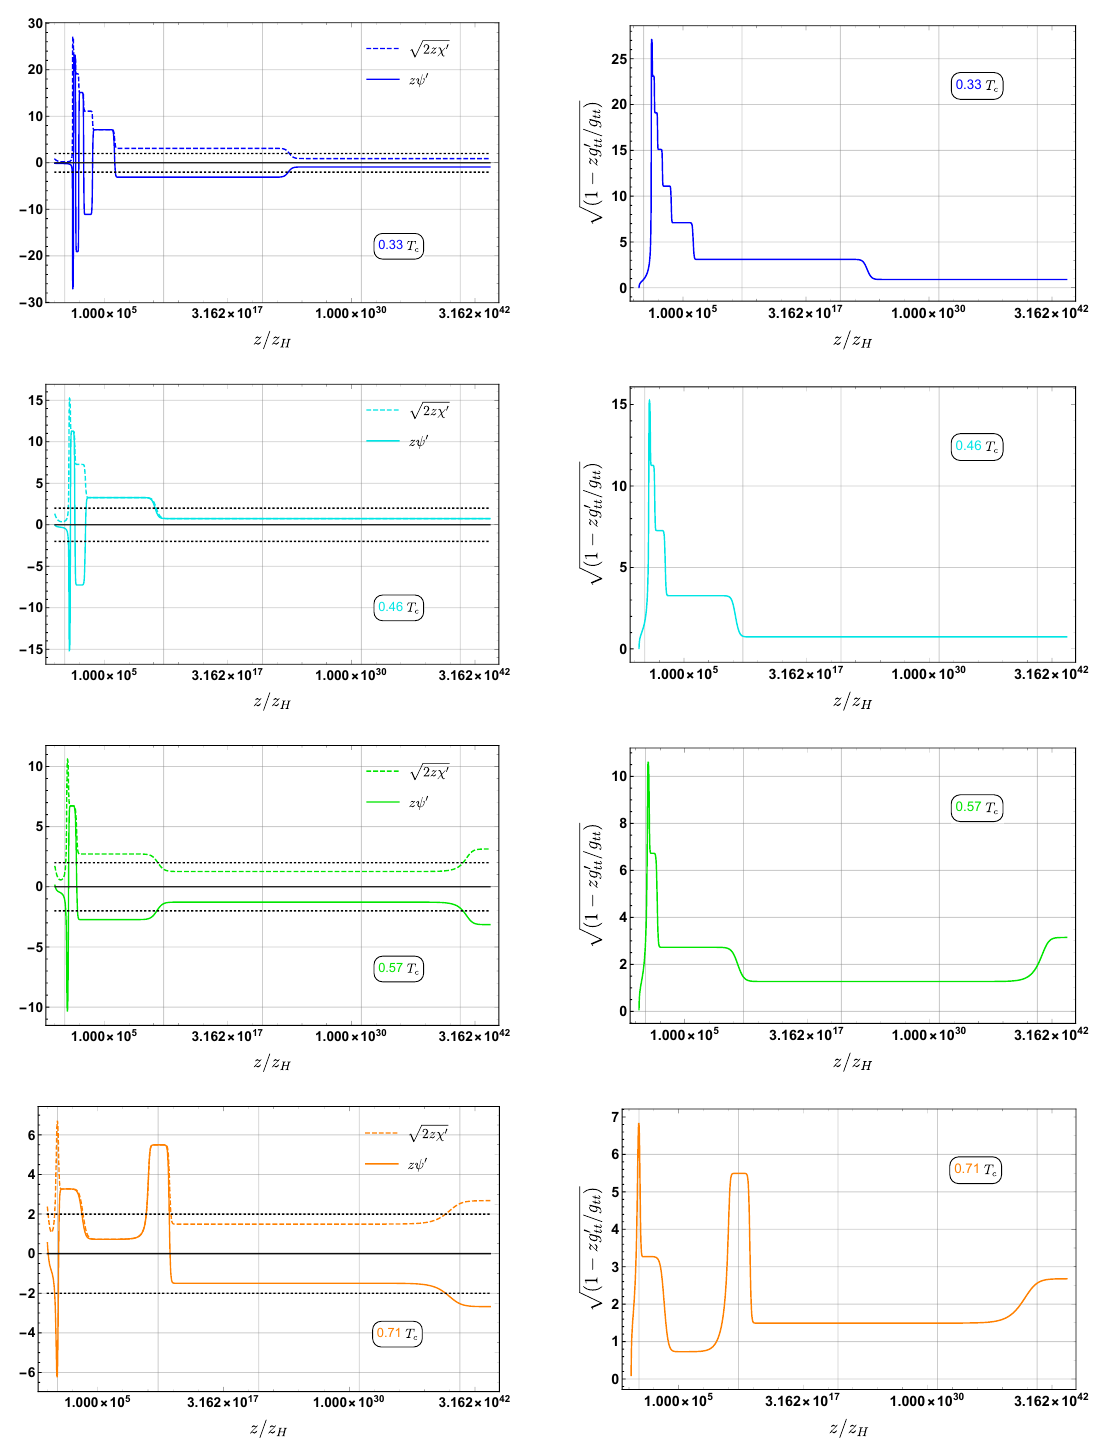
√ 2 zχ 0 (left) and p 1 − zg 0 /g tt (right) inside the supercon- tt = 0 . 33 , 0 . 46 , 0 . 57 and 0 . 71 , c